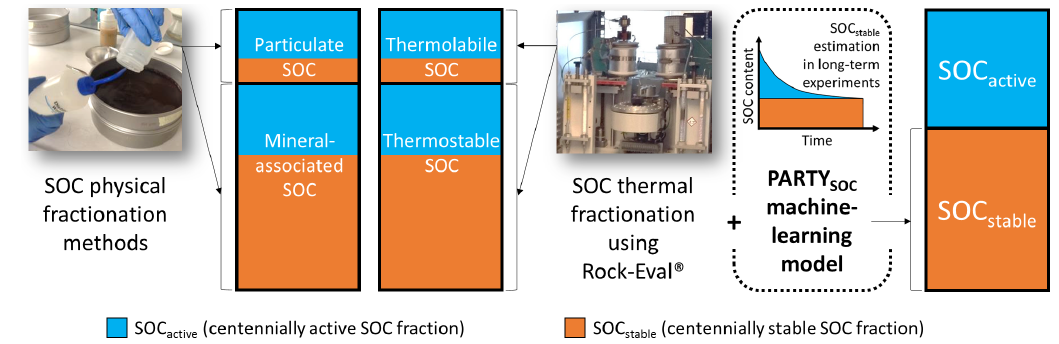
Figure 1. Conceptual representation of soil organic carbon fractionation methods vs. the PARTY SOC approach to quantify the size of the centennially stable and active soil organic carbon fractions. All existing soil organic carbon fractionation methods isolate fractions that are mixtures of centennially stable and active soil organic carbon. PARTY SOC is a machine-learning model trained on the Rock-Eval ® thermal analysis data for soil samples from long-term experiments in which the size of the centennially stable SOC fraction can be estimated. When applied to the Rock-Eval ® data for unknown topsoils, PARTY SOC partitions soil organic carbon into its active and stable fractions (i.e. without isolating soil organic carbon fractions from each other). SOC: soil organic carbon. Credits for photos: SOC physical fractionation methods, Mathilde Bryant; SOC thermal fractionation using Rock-Eval ® , Lauric